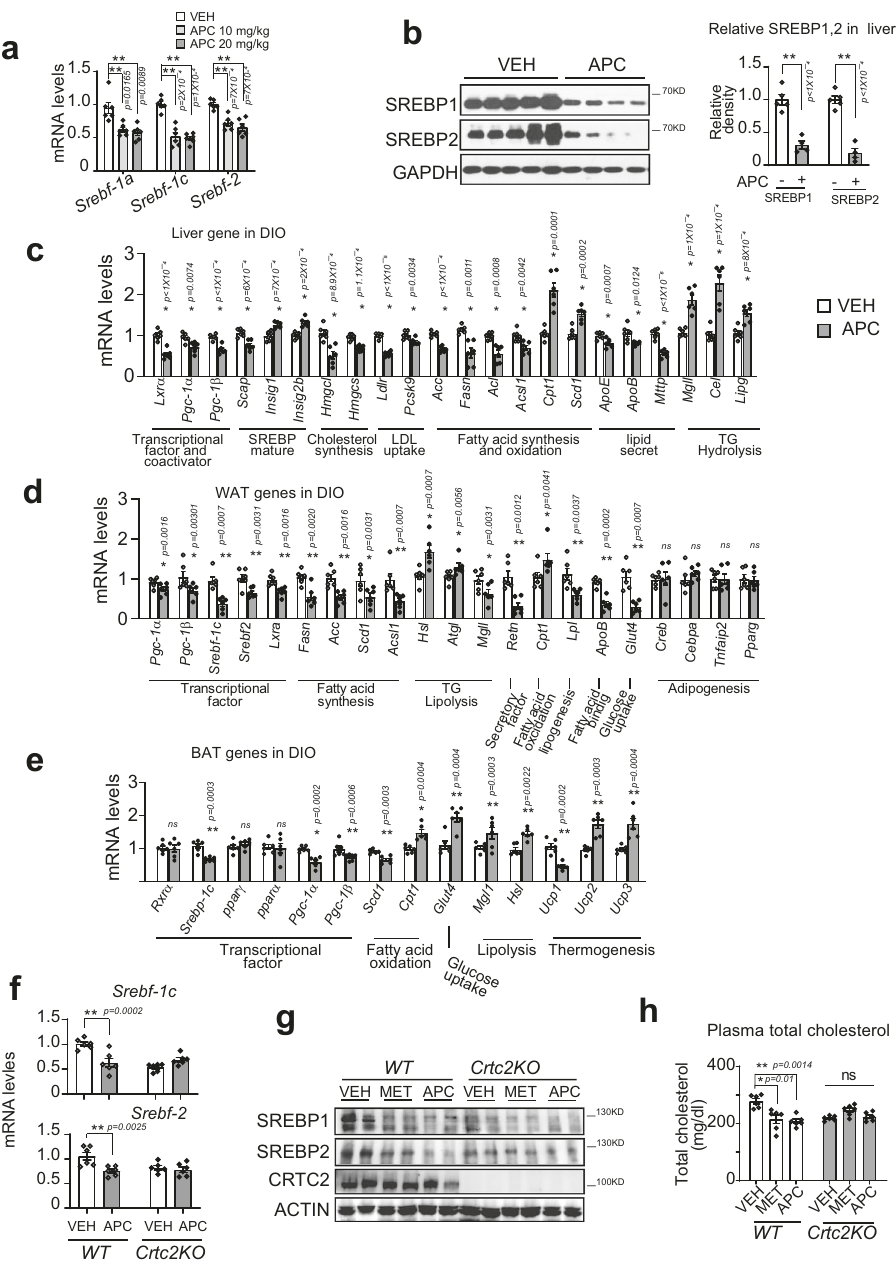
of novel compounds were designed and synthesized in order to summary, these data suggested that APC ameliorates obesity increase the inhibitory activity of CREB/CRTC2 protein-protein through increasing insulin sensitivity. interaction. (Fig. 9a, Supplementary Fig. 9, Supplementary Fig. 10a, and Supplementary Table 4). All the synthesized com- pounds were evaluated in vitro. Firstly, we reserved the 2-CF 3 group as R 2 , R 1 substitution was explored. Amide compounds displayed better inhibitory activity than carboxylic acid and ester derivatives. Then, we reserved pharmacophore α , β -unsaturated amide, and assessed the effect of substitutions of the phenyl. Both Figs. 1 – 8), we decided to design and discovery more potent the electron-donating and electron-withdrawing groups on the inhibitor of CREB/CRTC2 (Fig. 9 and Supplementary Figs. 9 and phenyl ring were tolerated for CREB/CRTC2 inhibition. The 10 and Supplementary Table 4). We then examined the inhibitory mono-substituted compounds demonstrated a regiochemical activities of a series of in-house compounds with similar struc- preference of ortho ≈ meta > para. When the R 2 group is 3-OMe, tures of APC by the CREB – CRTC2 two-hybrid system. For- compound A54 was afforded, the inhibitory activity of CREB/ tunately, compound A32 was discovered with an IC 50 value of CRTC2 protein-protein interaction increased with an IC 50 value 9.95 μ M, which displayed better inhibitory activity than APC. of 1.5 μ M, which is 16-fold more potent than APC. Finally, when Then, based on the structure of APC and compound A32 , a series NATURE COMMUNICATIONS| (2022) 13:246